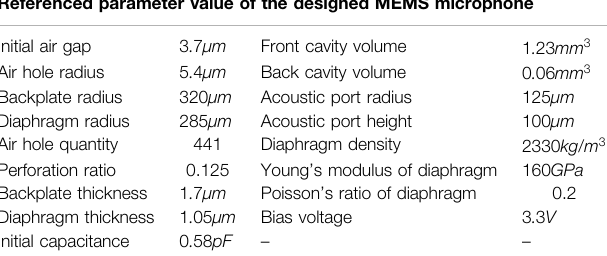
TABLE 2 | Pertinent dimensions and parameters used for the simulation of the MEMS microphone. Referenced parameter value of the designed MEMS